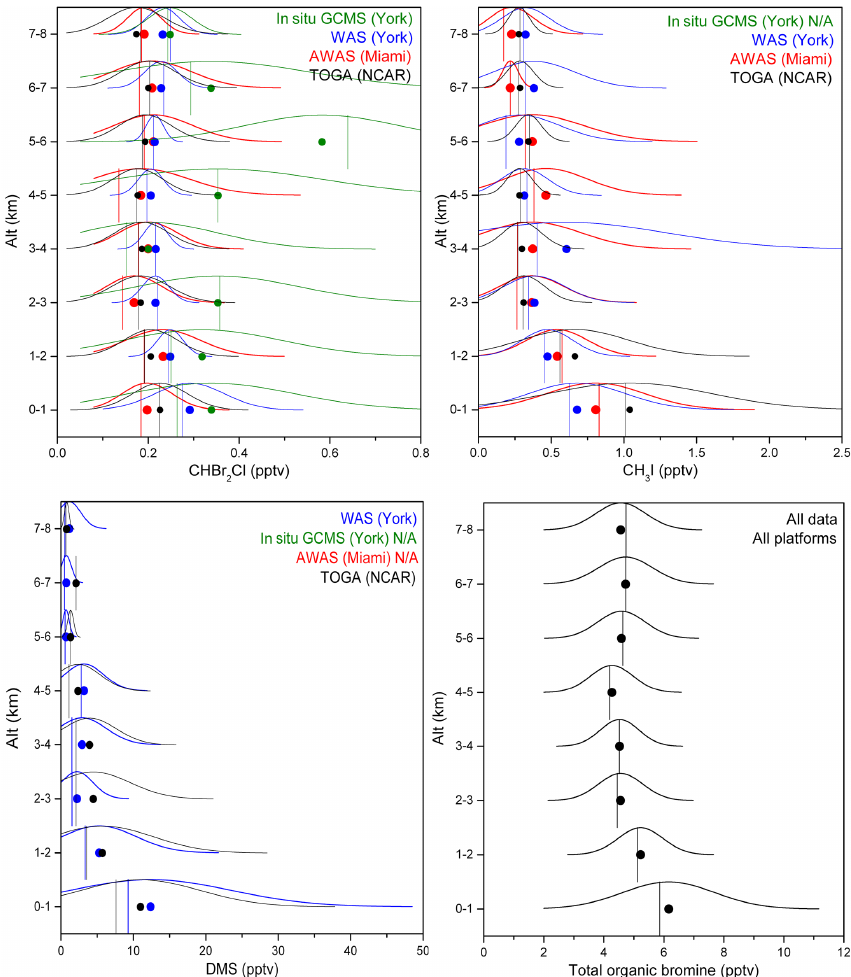
Figure 5. Vertical profile distribution bins for all species. WAS data have been adjusted as described in the text. “N/A” denotes cases where instruments have not analysed a compound. Bottom right: total organic bromine vertical profile calculated by the addition of all contributing bromine atoms from organic halocarbons, averaged across all instruments and sampling